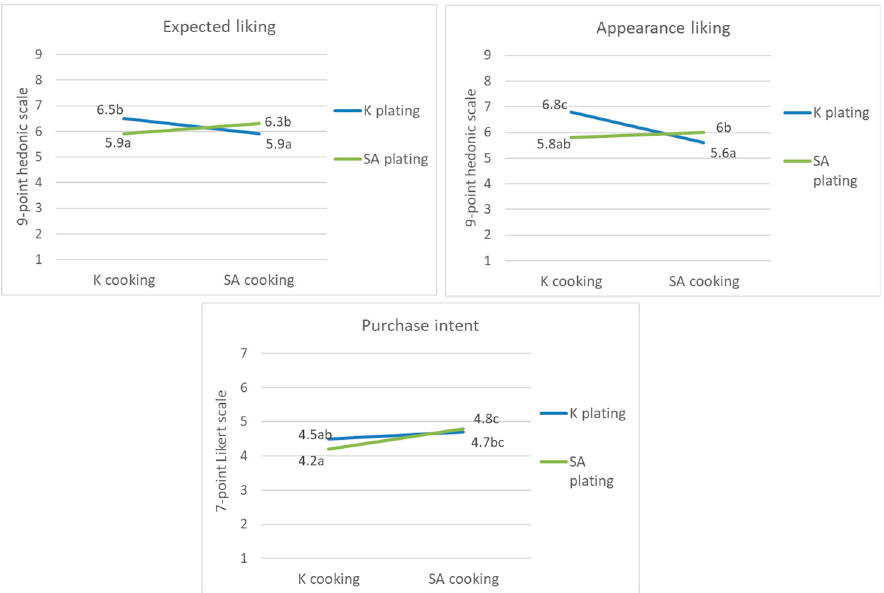
Figure 5. Effect of the cooking process × plating on expected liking, appearance liking, and purchase intent, di ff erent letters indicate significant di ff